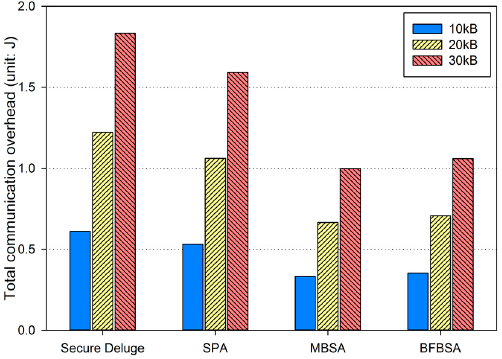
Figure 16. Total communication overhead.